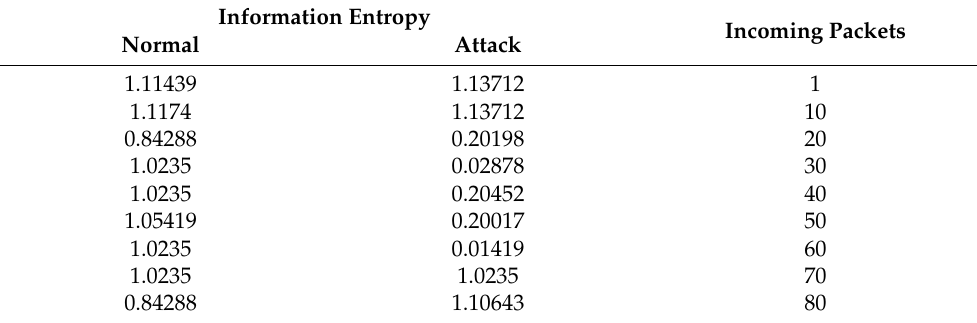
Table 2. Information entropy values.